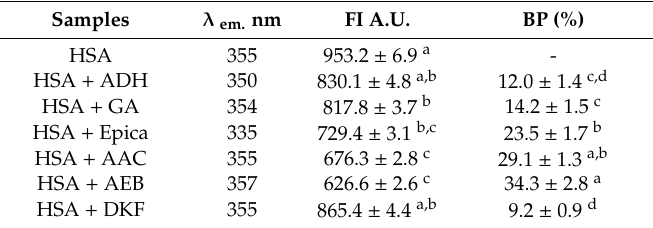
Table 2. Fluorometric measurements in two-dimensional fluorescence analysis (2D-FL) of kiwifruit and persimmon water